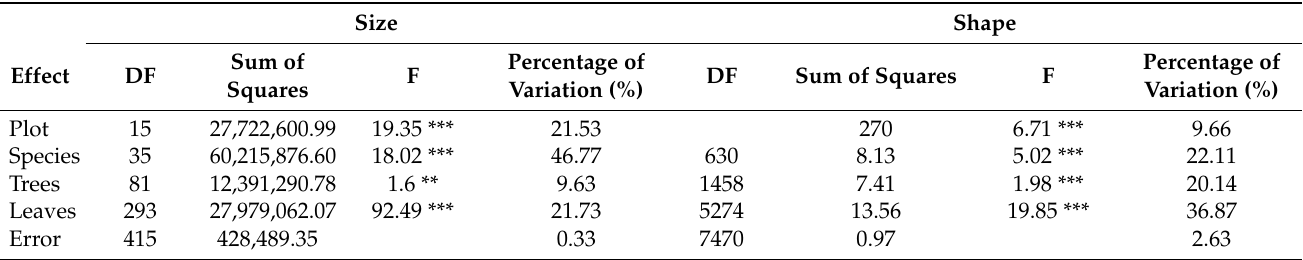
Table 1. Hierarchical analysis of variance for the centroid size (size) and conformation (shape) of the leaves. (DF refer to degrees of freedom. Significance: ***: p < 0.001, **: p < 0.01).